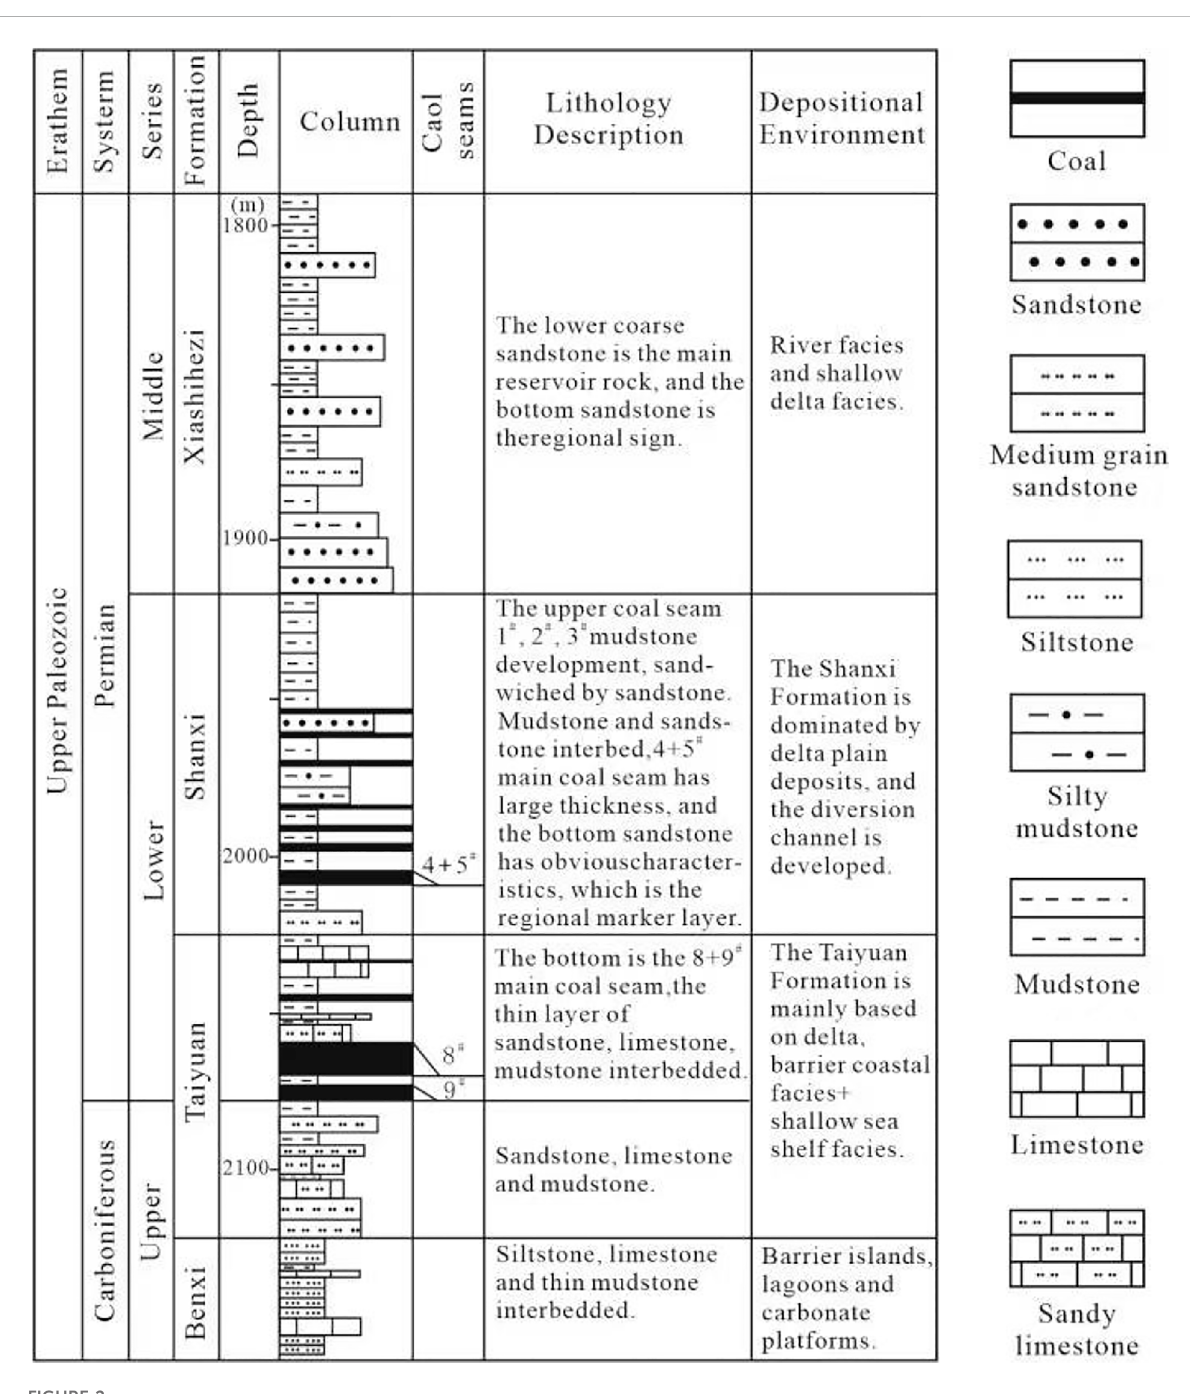
The location of wells used to collect samples can be found in Figure 1B. Figure 4A shows coal porosity variation with depth in deep coals. No obvious trend in porosity can be observed from 1,712.7 m to 2,088.1 m. The porosity values